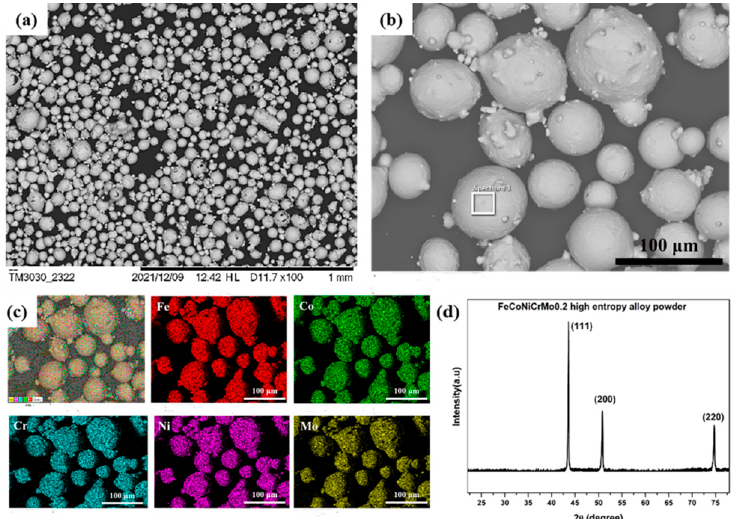
Figure 1. ( a , b ) SEM images of FeCoNiCrMo 0.2 high entropy alloy powder, ( c ) Element distribution of FeCoNiCrMo 0.2 high entropy alloy powder, ( d ) XRD patterns of FeCoNiCrMo 0.2 high entropy alloy powder.